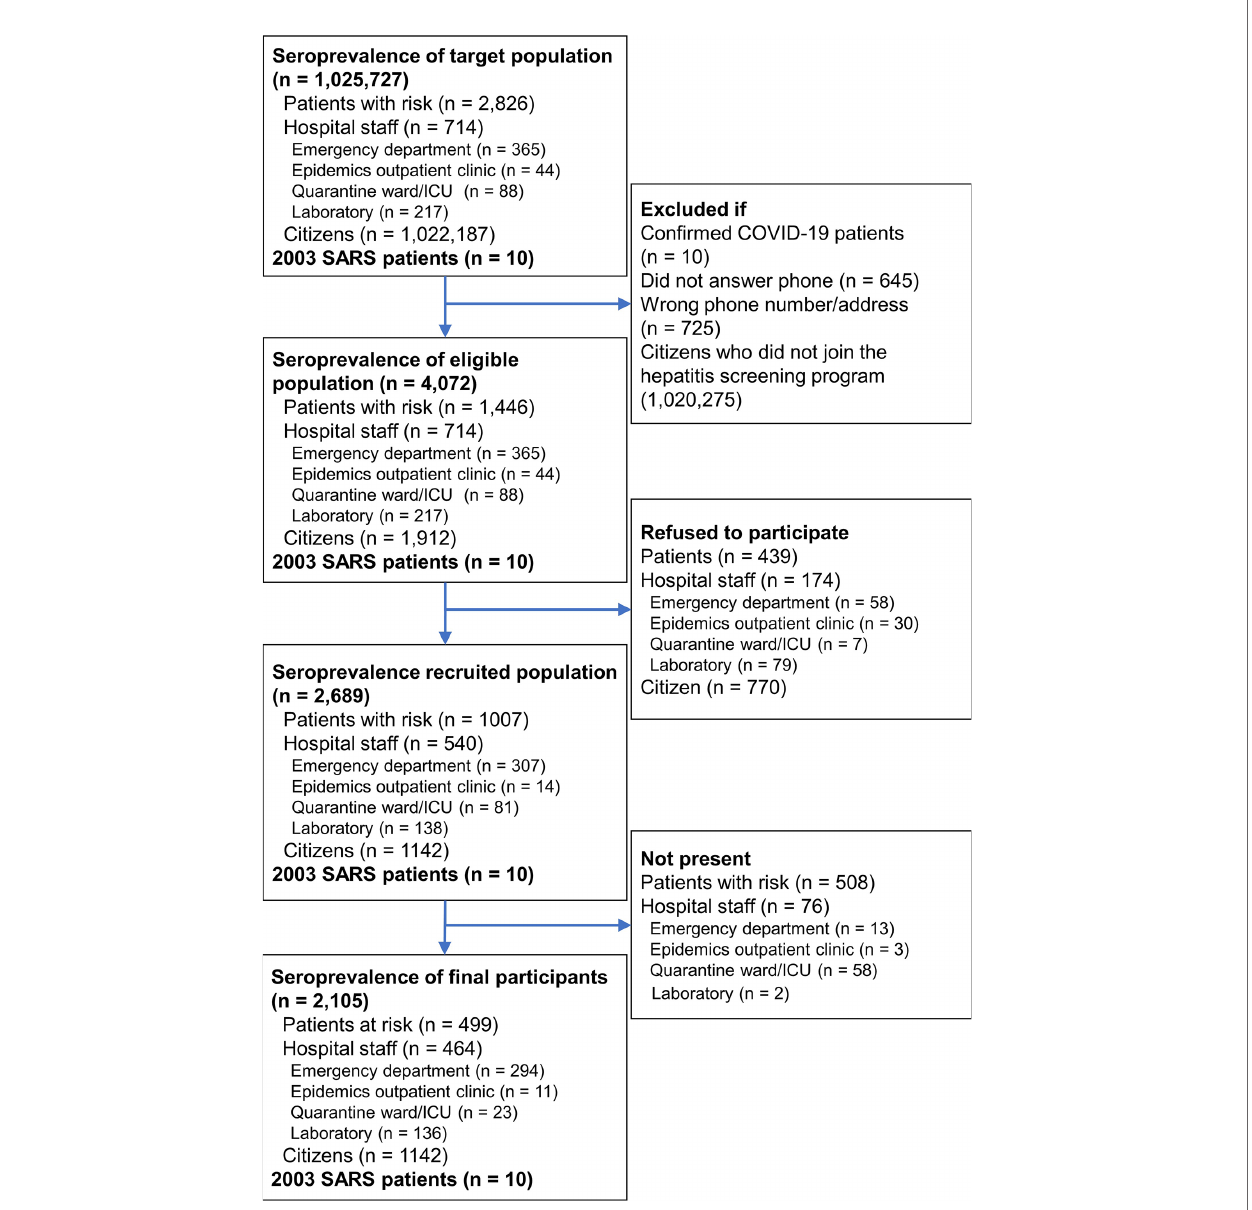
FIGURE 1 | Participants ’ enrollment fl